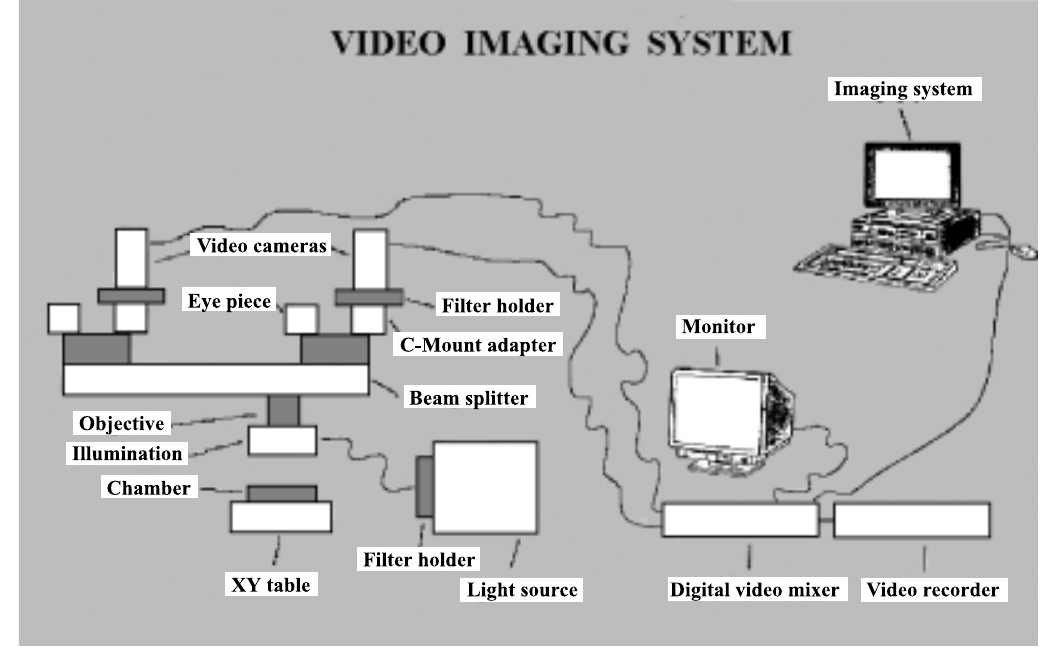
Fig. 1A – Schematic drawing of the experimental setup used for retina videomicroscopy